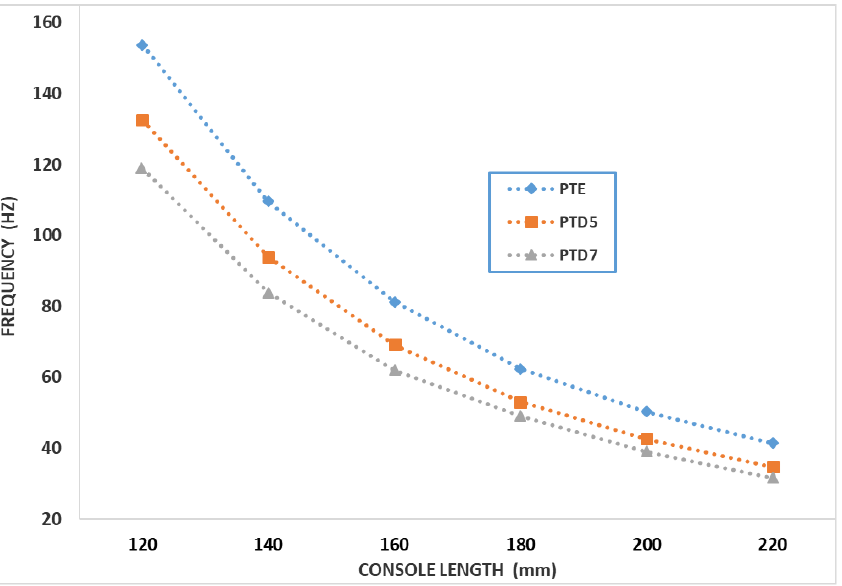
Figure 9. Variation of the vibration frequency as a function of the length of the bar console, for repre- sentative specimens from the PTE, PTD5 and PTD7